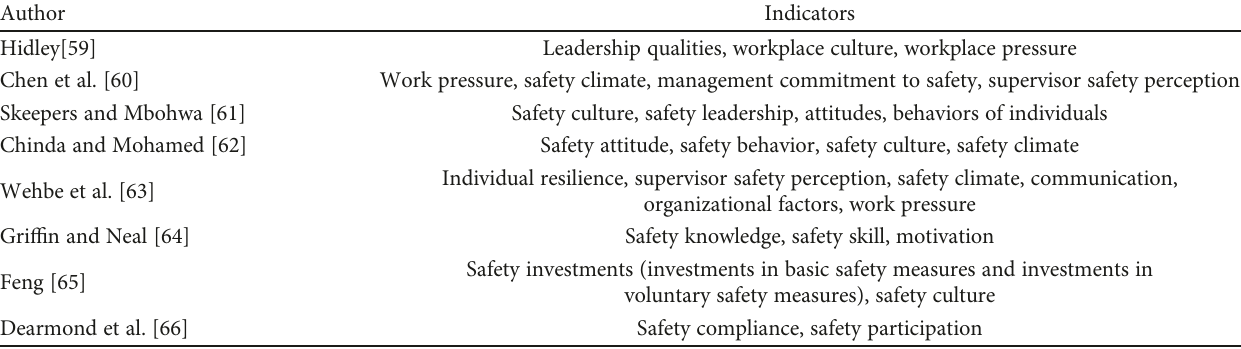
Table 3: System safety performance indicators in unsafe behavior in construction